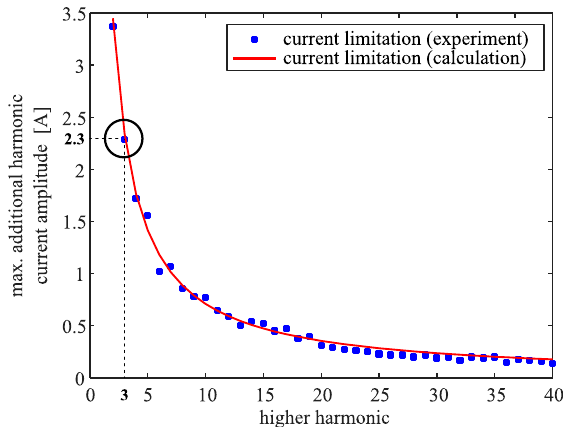
Figure 10. Comparison of calculated (by Equation (15)) and experimental current limitations, based on load current containing only fundamental harmonic with amplitude of 10 A.